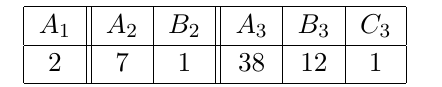
Table 3 . Distribution of the number of integrals over